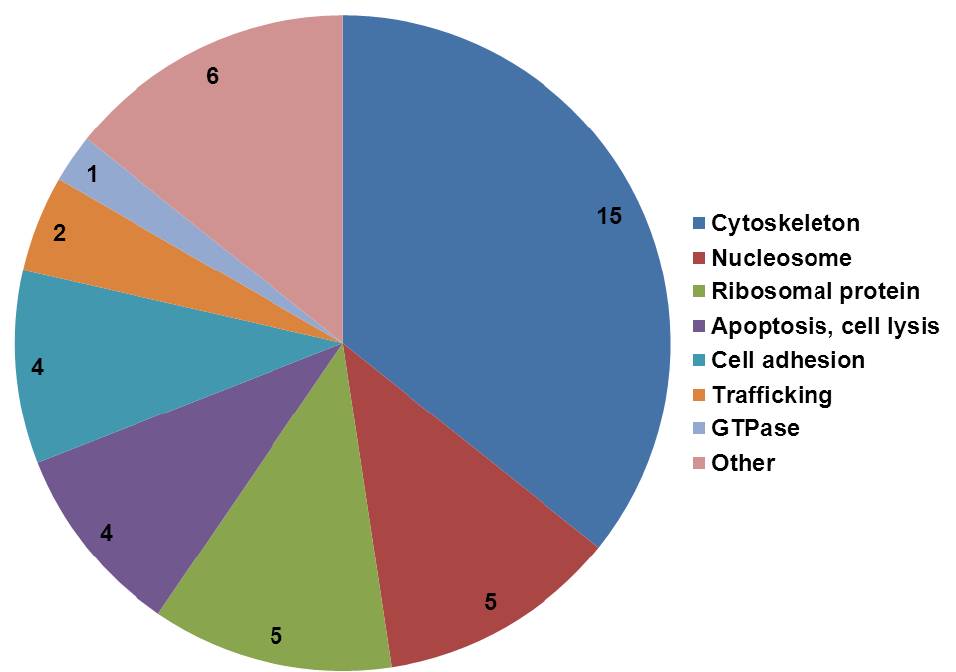
Figure 5. Distribution and characterization of the statistically significant modified proteins in PBEC exposed to PrP 106-126. PBEC were treated with 100 µM PrP 106-126 or with vehicle for 24 h. Proteins expression levels were analyzed using LC-MS (Section 4). Some of the proteins have overlapping functions.